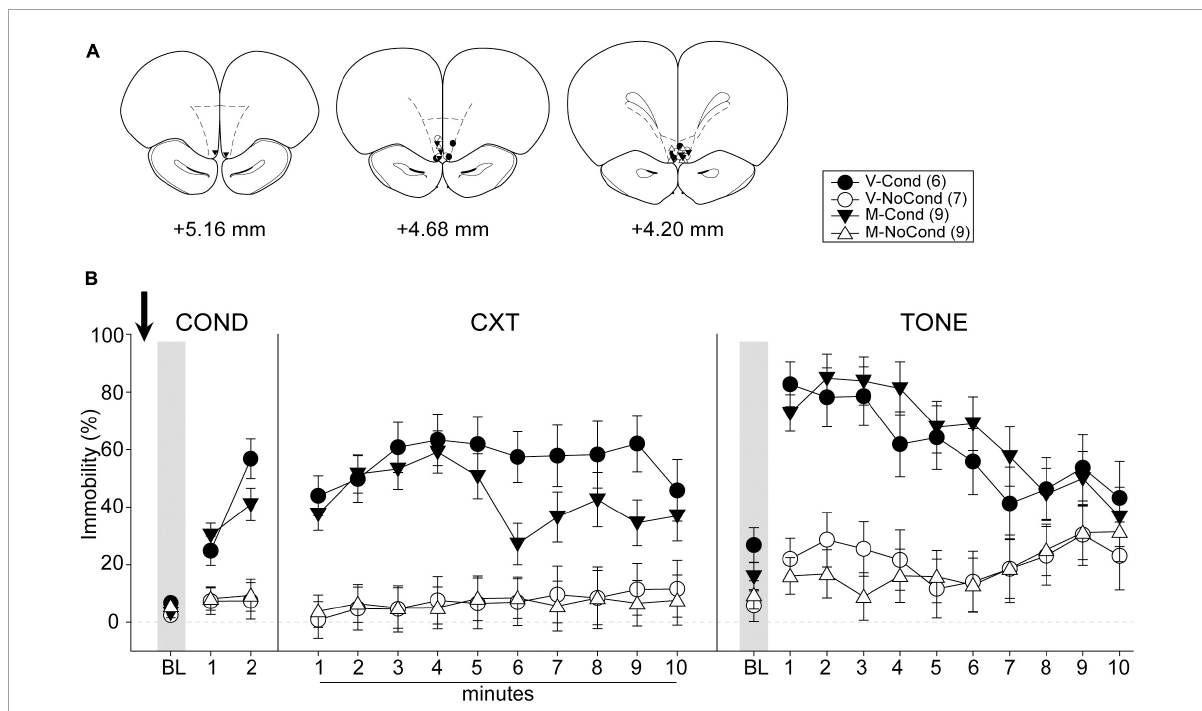
FIGURE6 Medial OFC (mOFC) inactivation during fear conditioning left the acquisition/consolidation of fear intact. (A) Injection sites in the mOFC for all the animals included in data analyses at levels of +5.16, +4.68, and +4.20 mm, anterior relative to bregma. (B) Percentage of immobility during the conditioning (left panel), contextual test (middle panel), and tone test (right panel). M, muscimol; V, vehicle; Cond, conditioning; NoCond, no-conditioning. All data are shown as the mean ±